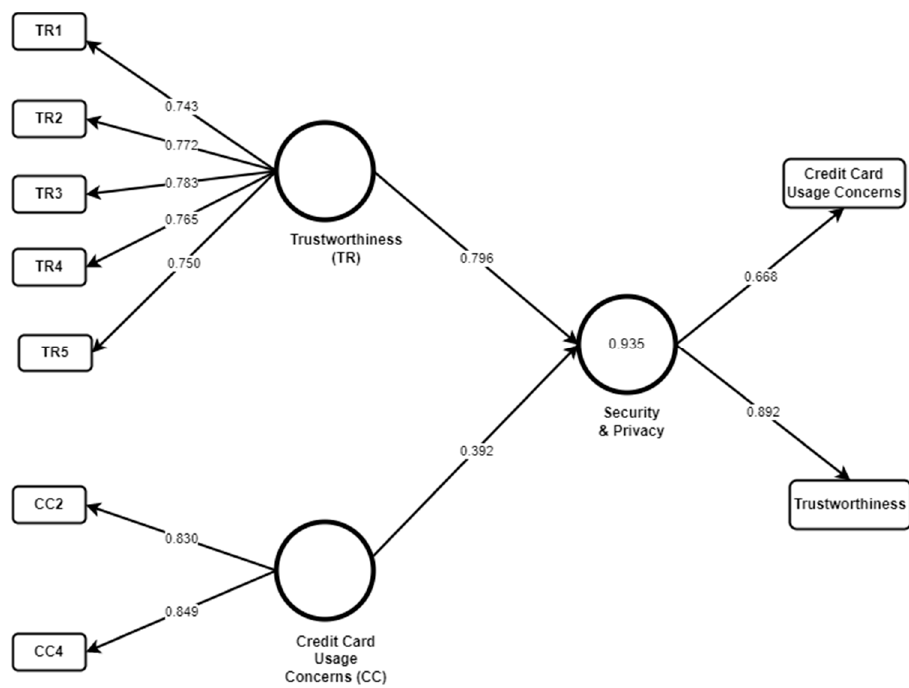
Figure 6. NOON Model.